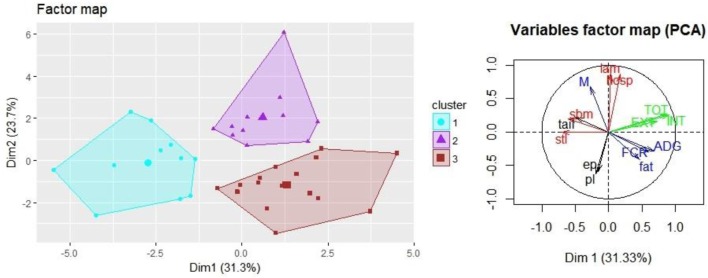
Principal component analysis (PCA) plot of the fattening farms (individual farms) and the variables on the two first components (CP1: 31.33%; CP2: 23.66%). Biosecurity [external (EXT), internal (INT), and total (TOT) biosecurity] is represented in green. The number of fattening pigs (fat) and the performance [average daily weight gain (ADG), feed conversion ratio (FCR), and mortality (MOR)] are represented in blue. Welfare outcomes [% pigs requiring hospitalization (hosp), lame pigs (lam), pigs with severe tail lesions (stl), and severe body marks (sbm)] are represented in red. Health indicators [% of enzootic pneumonia-like lesions (ep), pleurisy (pl), and tail-bitten lesions (tail)] are represented in black. A hierarchical clustering on the result of the PCA confirmed the partition in three clusters as the partition with the higher relative loss of inertia.